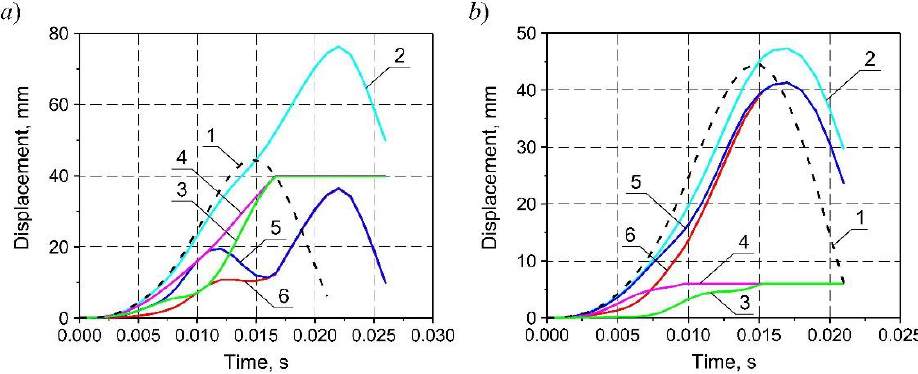
Fig. 7. Change of displacements of reinforced concrete slabs on rigid and yielding supports deformed gg  ): a – for 4 in in elasto-plastic phase with transition to the hardening phase ( e l e l 12 g  ; 1 – displacements in the center of the slab on g  ; b – for 200000 k N / m / m 10000 k N / m / m e l e l 1 1 rigid supports; 2 – full displacements in the center of the slab on yielding supports; 3 – displacement of support (node 16 fig. 2, a ); 4 – displacement of support (node 311 fig. 2, a ); 5 –maximum displacement of the slab in section 1-1 without considering deformation of supports; 6 – maximum displacement of the slab in section 2-2 without considering deformation of